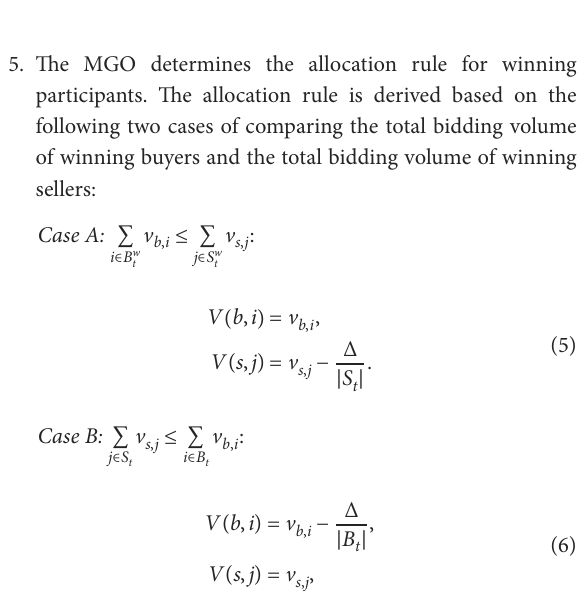
FIGURE 1 Market